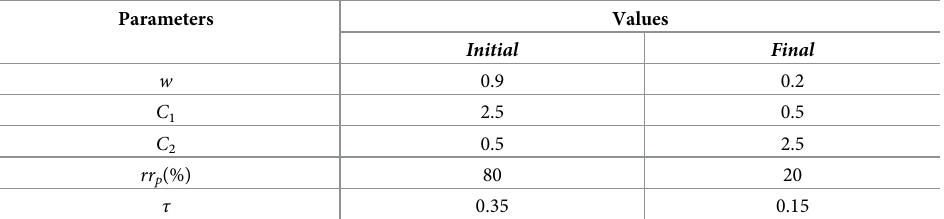
Table 1. The initial and final values for each PSO parameter in all application. Value range for w , C 1 , C 2 , rr p and τ used in this research.